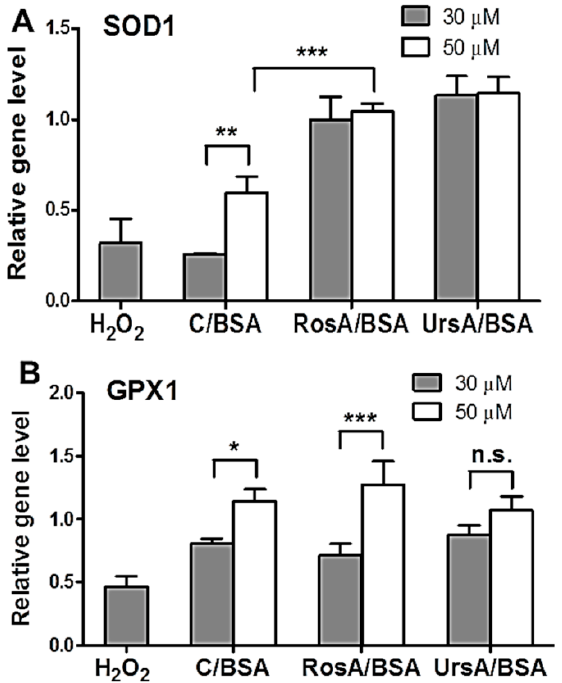
Figure 8. Antioxidant gene expression level analysis by qRT-PCR assay. The experiments were performed to confirm the antioxidant gene levels, such as ( A ) SOD1 and ( B ) GPX1, in the ARPE cells after treatment with formulations (up to 50 µM of drugs) and then H 2 O 2 . Relative gene levels in the treated cells were calculated by comparison with the basic gene levels in the untreated control cells. The star (*) symbol indicates the significant difference (* p < 0.05, ** p < 0.01, and *** p < 0.001) by one-way ANOVA test with a significance level of 0.05. n.s. means “not significant”.